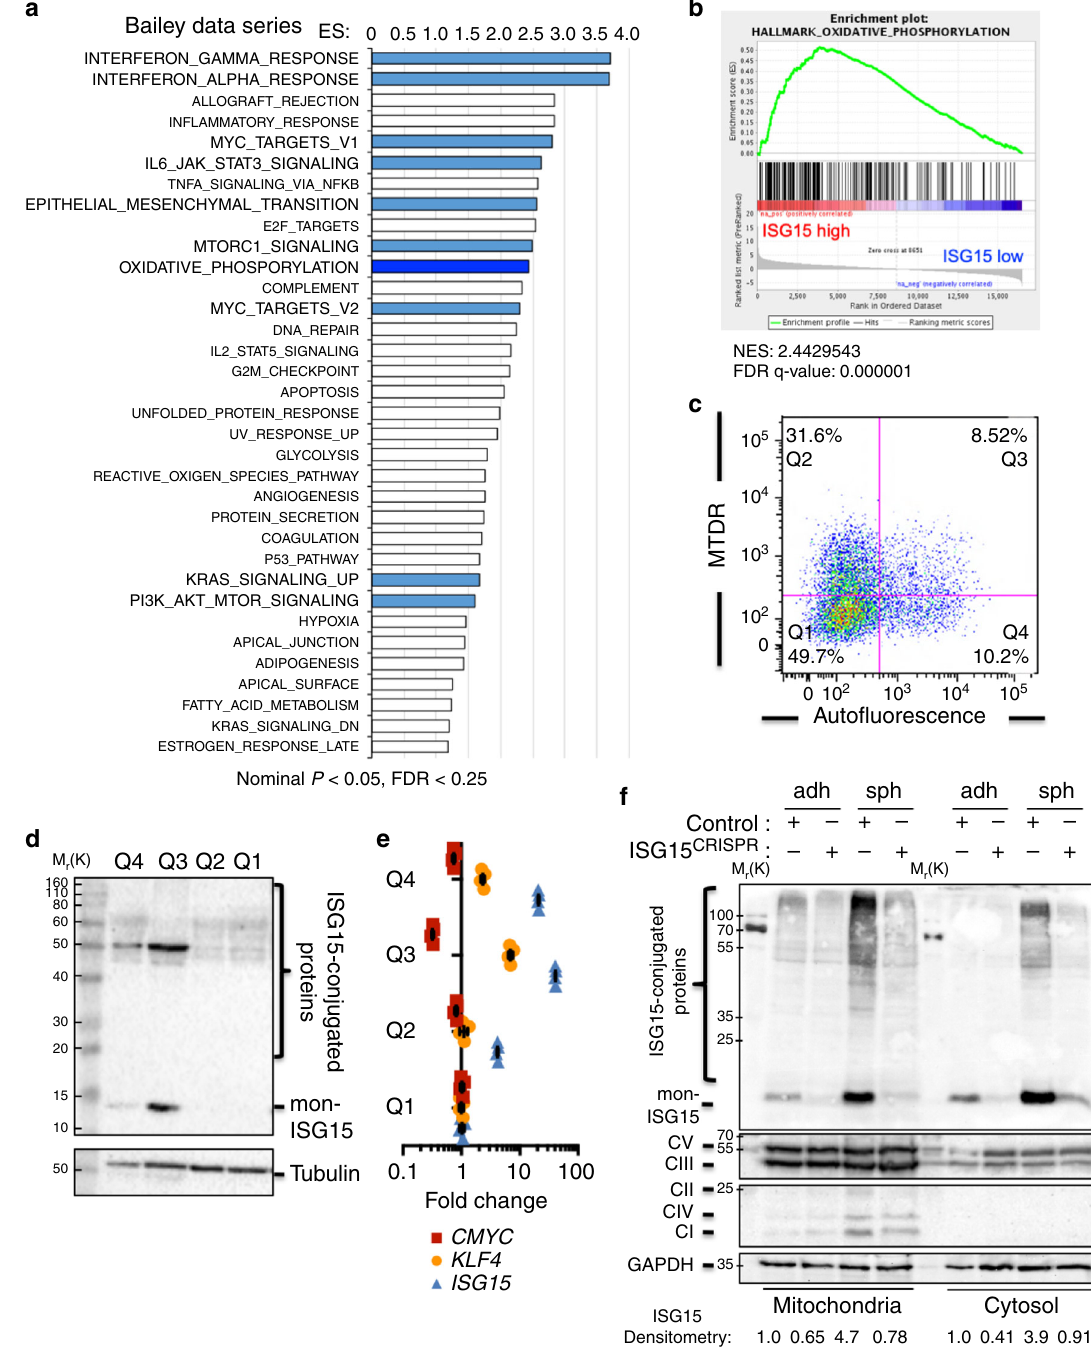
Fig. 2 ISG15 expression is linked to mitochondria-related pathways. a Gene sets enriched in the transcriptional pro fi le of tumors belonging to the top ISG15 high-expression group, compared with the bottom expression group in the Bailey data series. Shown are the NES (normalized enrichment score) values for each pathway using the Hallmark genesets, meeting the signi fi cance criteria: nominal p -value of <0.05, FDR < 25%. b Enrichment plot for OXPHOS signaling in ISG15 high versus low. c Auto fl uorescence (CSC) and Mitotracker Deep Red (MTDR, approximation of mitochondrial mass) were combined to sort the four gated populations (Q1 – Q4) from Panc185 spheres. d WB analysis of ISG15 protein expression in the four FACS sorted populations in c . Tubulin was included as a loading control. e RTqPCR analysis of CMYC , KLF4 and ISG15 gene mean fold change ± sd in the four FACS sorted populations in c ( n = 3 replicates from one independent sorting experiment). Values compared to Q1, set as 1.0. f WB analysis of ISG15 protein expression in mitochondrial and cytosolic fraction from Panc185 Control or CRISPR-Cas9 ISG15-edited (ISG15 CRISPR ) CSCs (sph) and non-CSCs (adh). The membrane was additionally blotted for mitochondria OXPHOS complex proteins using the Mitopro fi le Total OXPHOS antibody cocktail in addition to GAPDH (loading control). Shown are bands corresponding to Complex (C)V, CIII, CII, CIV, and CI. Total ISG15 expression [ISG15-conjugated and monomeric (mon-) proteins] for each sample was quanti fi ed by densitometric analysis and fold changes are shown, relative to control adherent (adh), set as 1.0 for both mitochondria and cytosolic